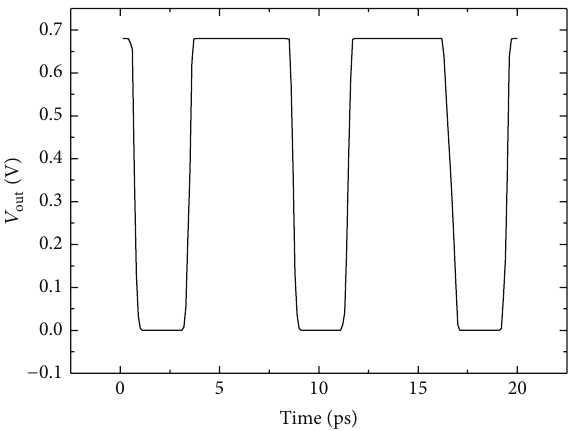
Figure 5: Charging current network diagram.